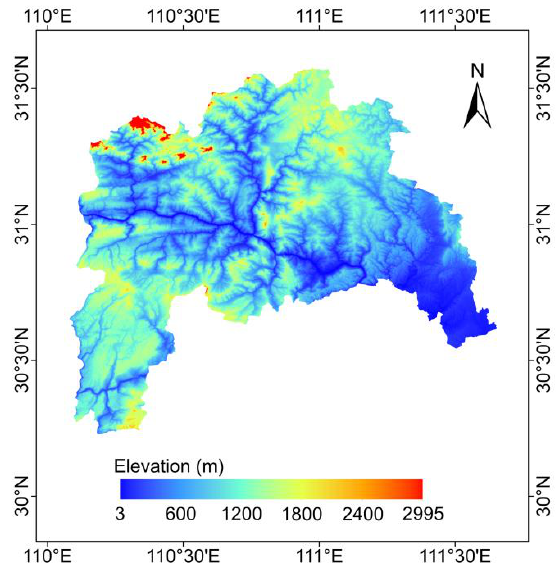
Figure 2. Elevation (SRTMGL1) of the study area.